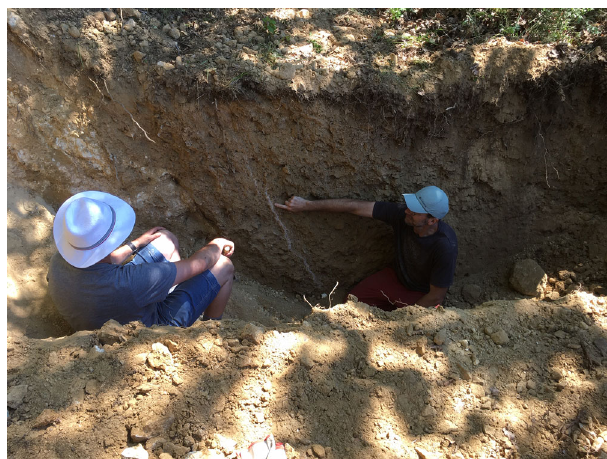
Fig. 2 Detail picture of a trench wall excavated across the causative fault. This is from the fi rst trench out of a dozen that was dug during the 2020 spring; notice the fracture in the colluvium related to a pre-historical activity, with the two authors for